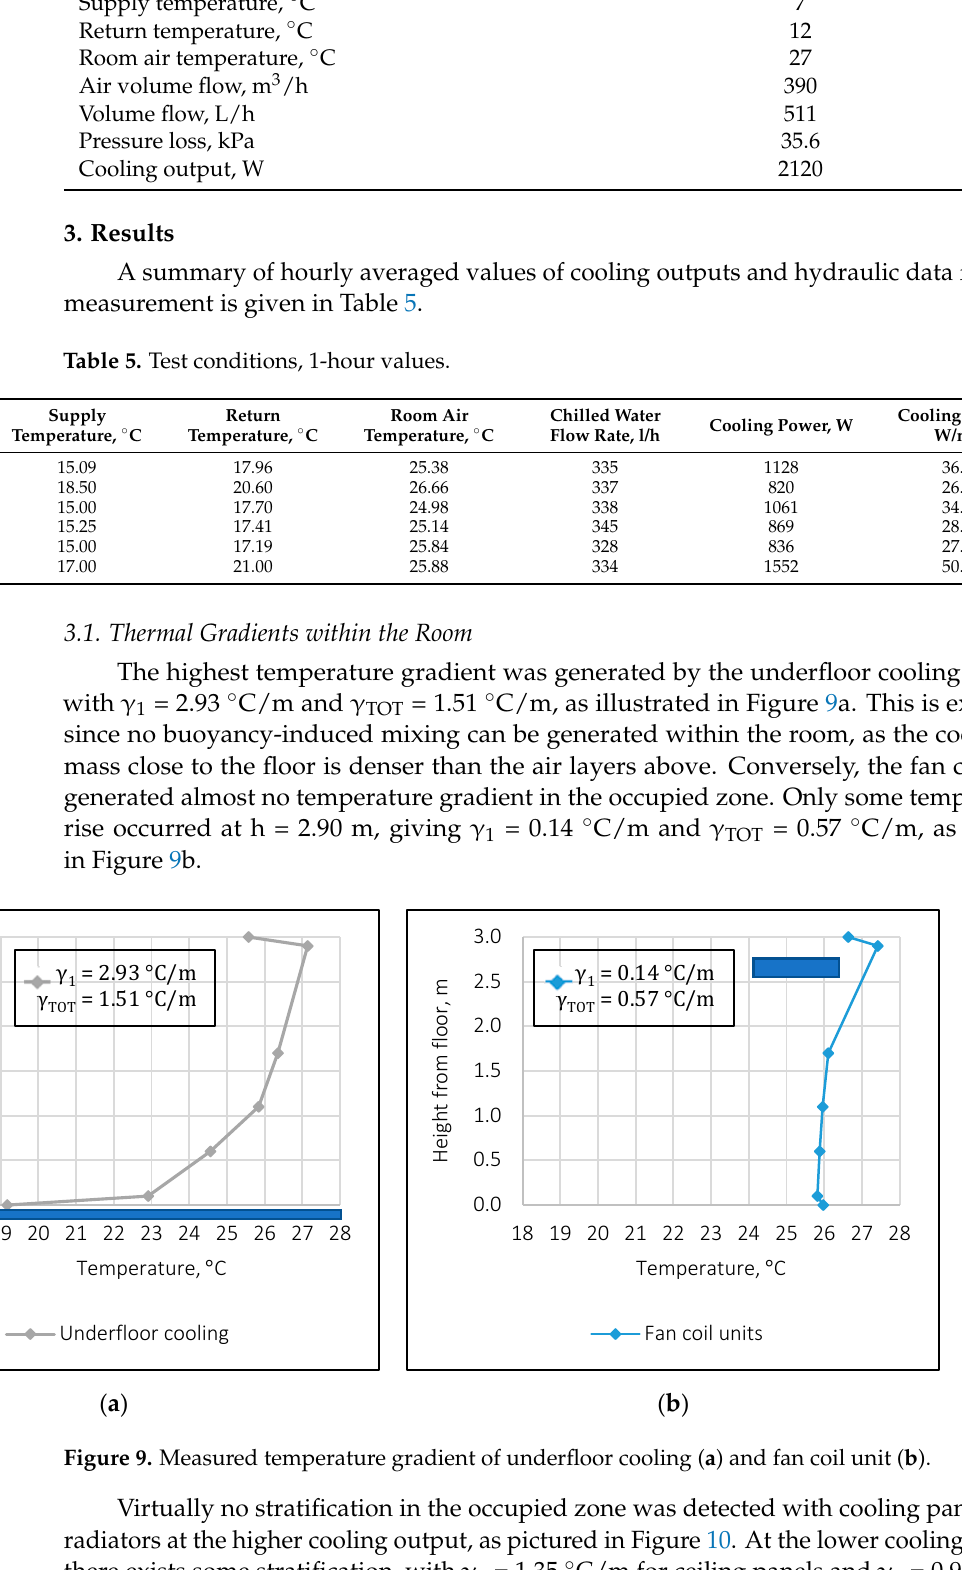
Figure 9. Measured temperature gradient of underfloor cooling ( a ) and fan coil unit ( b ). Virtually no stratification in the occupied zone was detected with cooling panels and radiators at the higher cooling output, as pictured in Figure 10. At the lower cooling output, there exists some stratification, with γ 1 = 1.35 ◦ C/m for ceiling panels and γ 2 = 0.97 ◦ C/m for